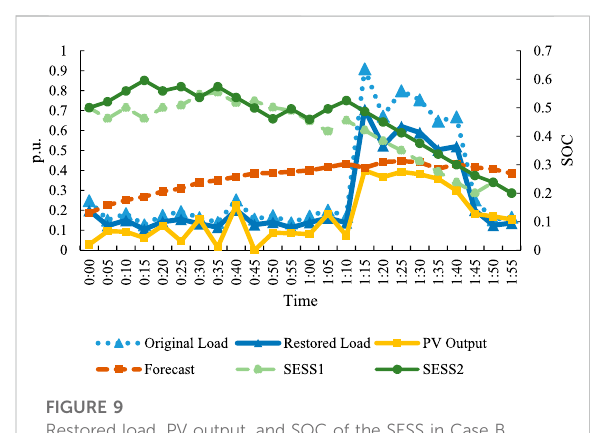
FIGURE 10 SOC result of the MESS in Case